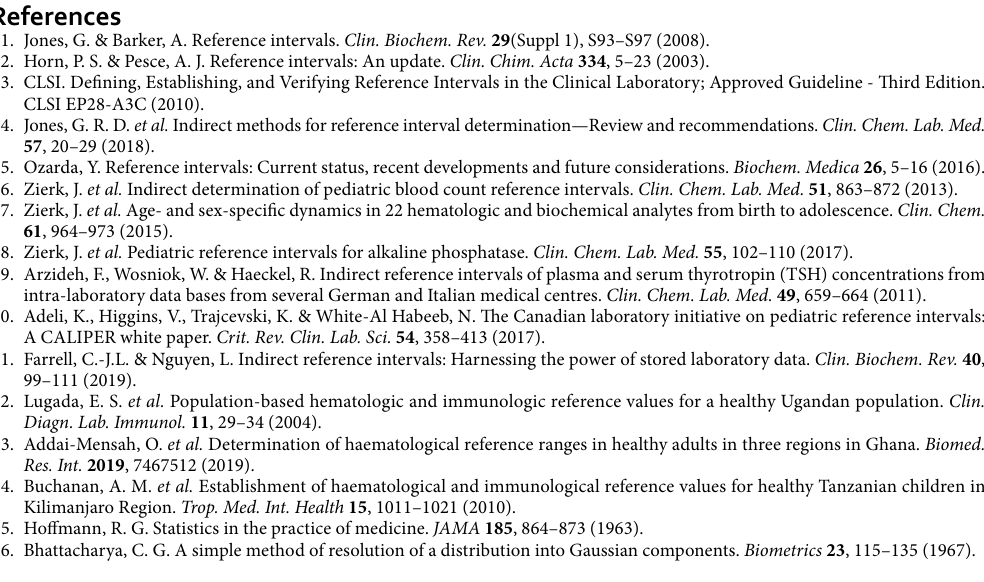
Figure 4. Comparison of reference intervals estimated with the refineR and kosmic algorithm using pediatric RWD to reference intervals published in literature. Each plot ( a – f ) shows for the indicated biomarker the estimated lower (left) and upper (right) reference limit obtained using refineR (blue) and kosmic (orange) in comparison to published reference intervals established using direct methods (grey) 31–40 . The squares represent the point estimates while the whiskers show the 95% confidence interval (* indicates 90% confidence interval). The lightgrey area illustrates the margin of variation of the different direct studies (meaning the range from the minimum lower confidence limit (or point estimate) to the maximum upper confidence limit (or point estimate)). Please note that age ranges between indirect methods and published direct methods do not perfectly match. The numeric values for the reference intervals can be found in Supplementary Table